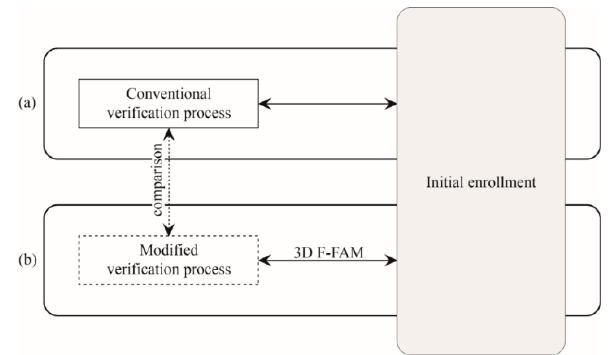
Figure 3. Diagram of the verification process for ( a ) conventional verification and ( b ) modified verification.